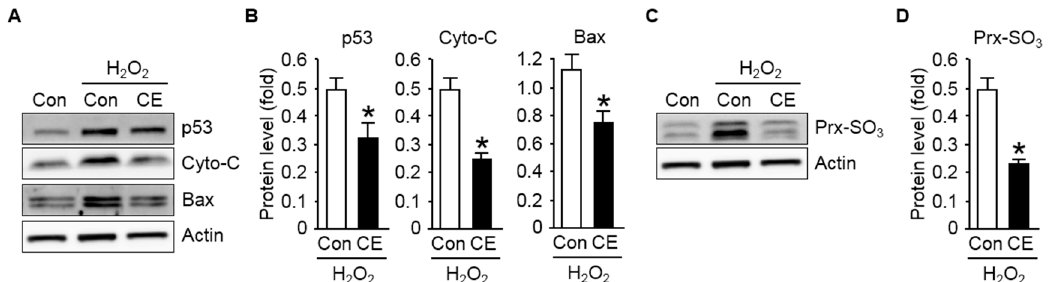
Figure 3. E ff ect of CE on p53 activation in human lung cells exposed to oxidative stress: ( A ) immunoblot analysis of p53, cytochrome c (Cyto-C), and Bax with the loading control actin; ( B ) results of p53, Cyto-C, and Bax quantification normalized to the expression of actin are shown; ( C ) immunoblot analysis of oxidized peroxiredoxin (Prx-SO 3 ) levels in NCI-H460 cell lysates—actin served as the loading control; ( D ) the protein levels of Prx-SO 3 were normalized to those of actin to quantify the immunoblotting data. All data are presented as the mean ± S.D. from three independent experiments. * p < 0.05 versus cells exposed to H 2 O 2 .